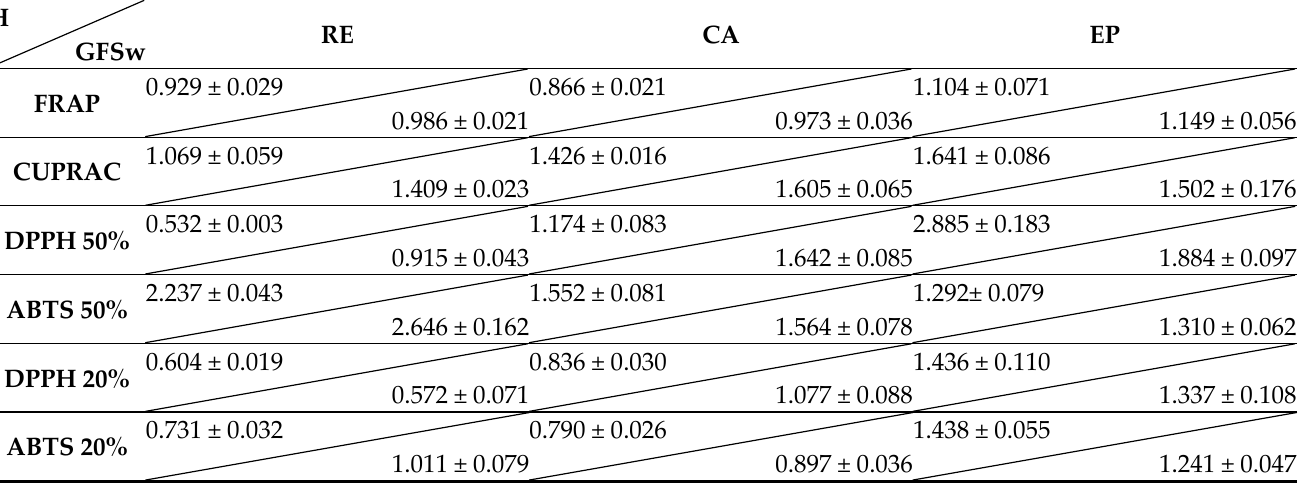
Table 8. CI values for AOA activity from Tables 3 and 7 together.